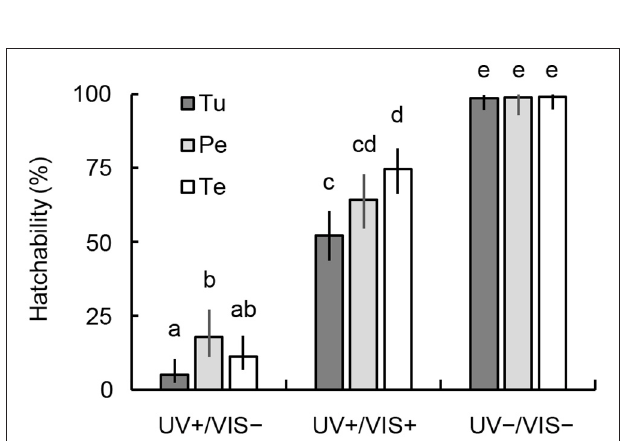
FIGURE 3 | Comparison of the hatchability of N. californicus eggs produced by females fed mites or pollen with and without photoreactivation after irradiation with UVB at 0.38 kJ m − 2 . UV + , irradiated with UVB; UV–, untreated control. Prey and food sources of parental females were T. urticae (Tu), peach pollen (Pe), and tea pollen (Te). Vertical lines on bars show 95% CI. Different letters in each bar denote statistically significant differences (Fisher’s exact test, P < 0.05).